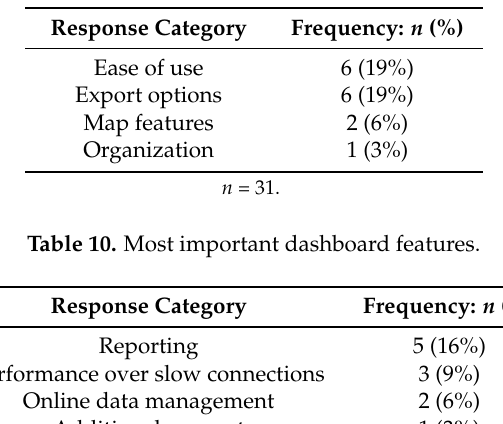
Table 9. Main benefits of dashboard.